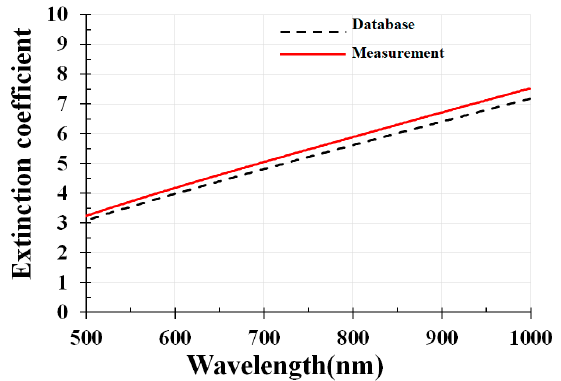
Figure A2. The extinction coefficients of Ag versus wavelength from measurement and database. Coatings 2018 , 8 , x